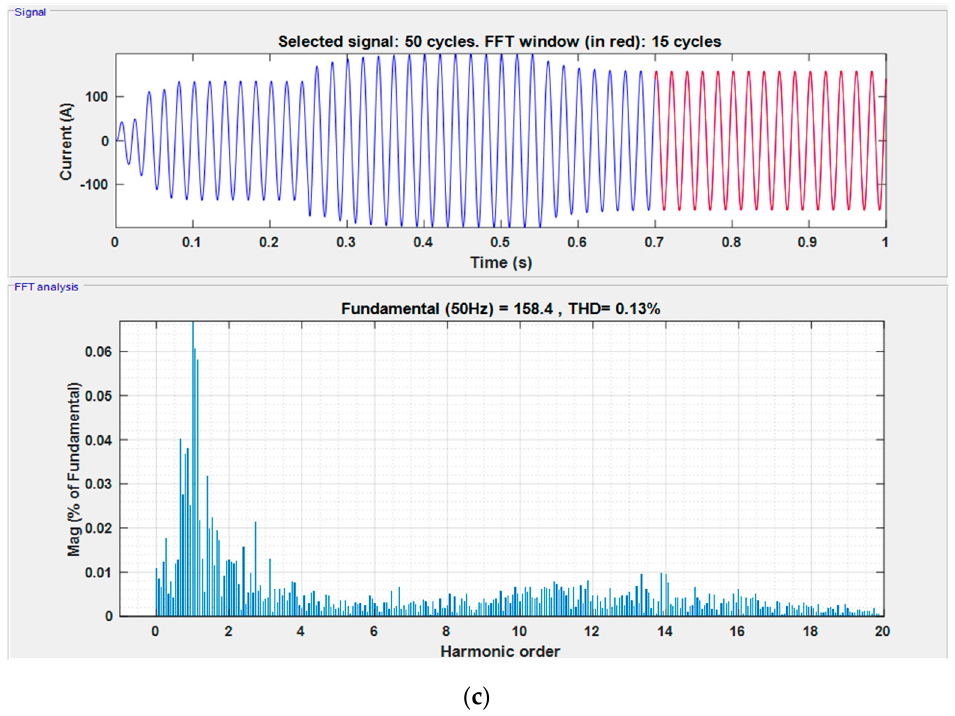
Figure 11. FFT analysis of studied MG system during ( a ) DG injection, ( b ) load injection and ( c ) load detachment.